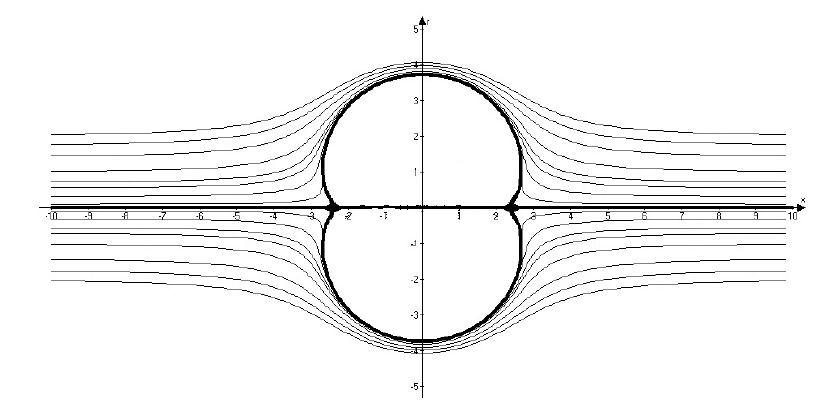
Figure 5: The streamline along a toroidal solid without a